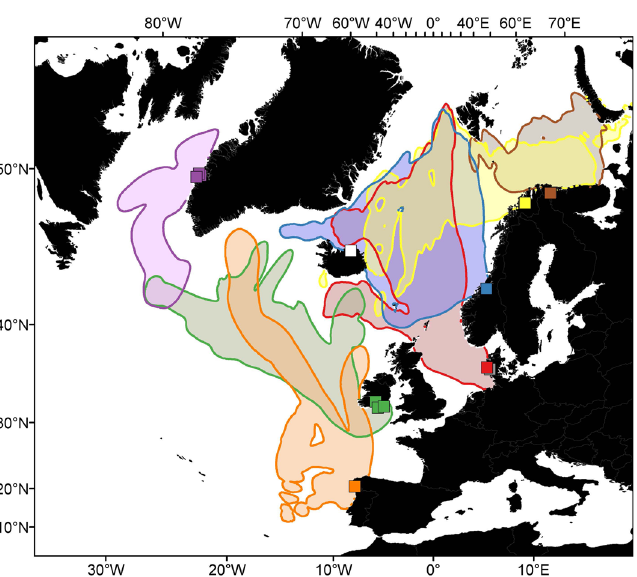
Figure 4. Area use during the ocean migration of tagged Atlantic salmon, shown with lines and shades with colors representing salmon from seven different areas (same color codes as in Fig. 1, with the two populations from Denmark combined due to the proximity and similarity of movements for fish of these rivers). Data from salmon tagged in Iceland were not included due to a small sample size. The area use is based on combined residency distributions for all fish from each population. Temporal area use is not considered here. The more detailed spatial intensity information within each population distribution is shown in Supplementary Figure S2. Maps were drawn using ESRI ArcGIS Desktop